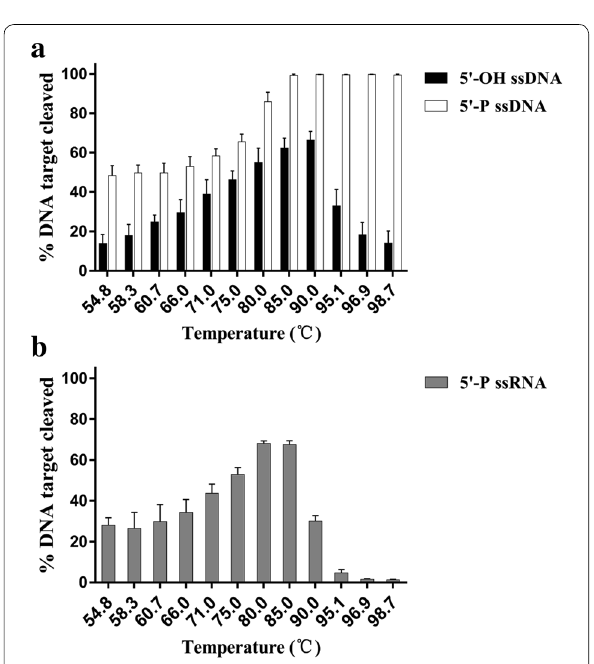
Fig. 4 Effect of temperature on Mf Ago activity. a Effect of temperature on Mf Ago activity mediated by 5 ′ -P ssDNA and 5 ′ -OH ssDNA guides. b Effect of temperature on Mf Ago activity mediated by 5 ′ -P ssRNA guide. Error bars represent the SDs of three independent